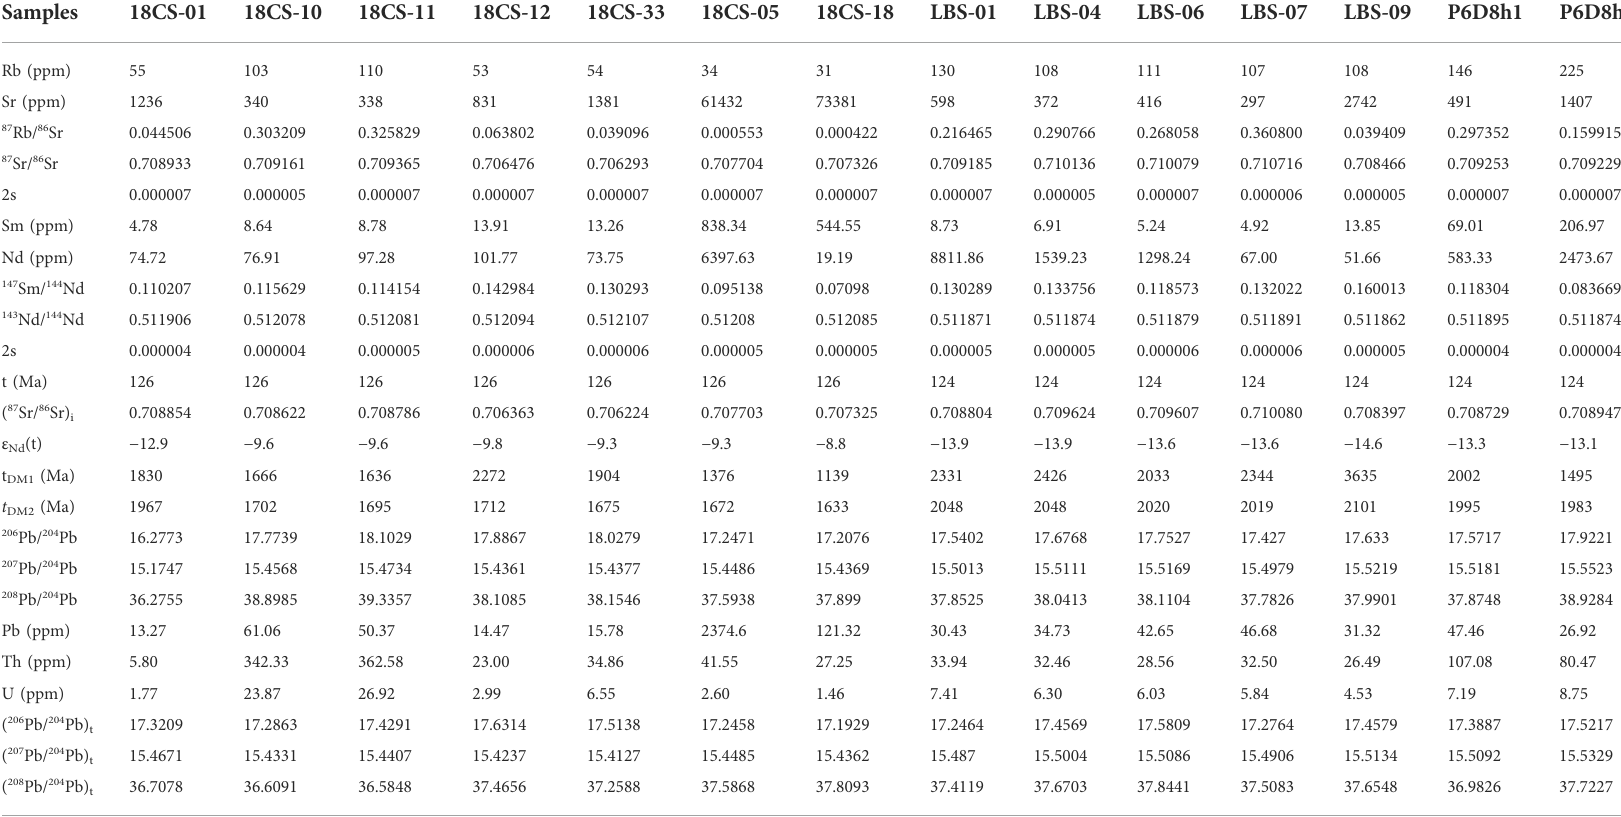
TABLE 3 Sr-Nd-Pb isotopic compositions of the quartz syenite, REE ore samples, and altered rocks from Chishan and Longbaoshan REE deposits.